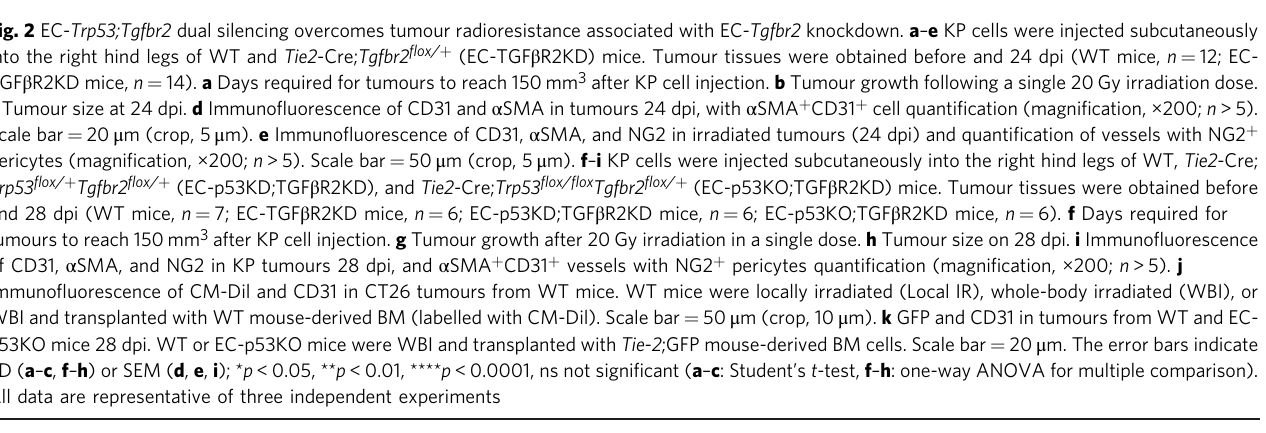
Fig. 2 EC- Trp53;Tgfbr2 dual silencing overcomes tumour radioresistance associated with EC- Tgfbr2 knockdown. a – e KP cells were injected subcutaneously into the right hind legs of WT and Tie2 -Cre; Tgfbr2 fl ox/ + (EC-TGF β R2KD) mice. Tumour tissues were obtained before and 24 dpi (WT mice, n = 12; EC- TGF β R2KD mice, n = 14). a Days required for tumours to reach 150 mm 3 after KP cell injection. b Tumour growth following a single 20 Gy irradiation dose. c Tumour size at 24 dpi. d Immuno fl uorescence of CD31 and α SMA in tumours 24 dpi, with α SMA + CD31 + cell quanti fi cation (magni fi cation, ×200; n > 5). Scale bar = 20 μ m (crop, 5 μ m). e Immuno fl uorescence of CD31, α SMA, and NG2 in irradiated tumours (24 dpi) and quanti fi cation of vessels with NG2